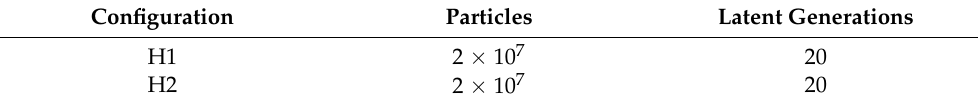
Table 17. Numerical simulation parameters for CROCUS configurations during adjoint simulations.